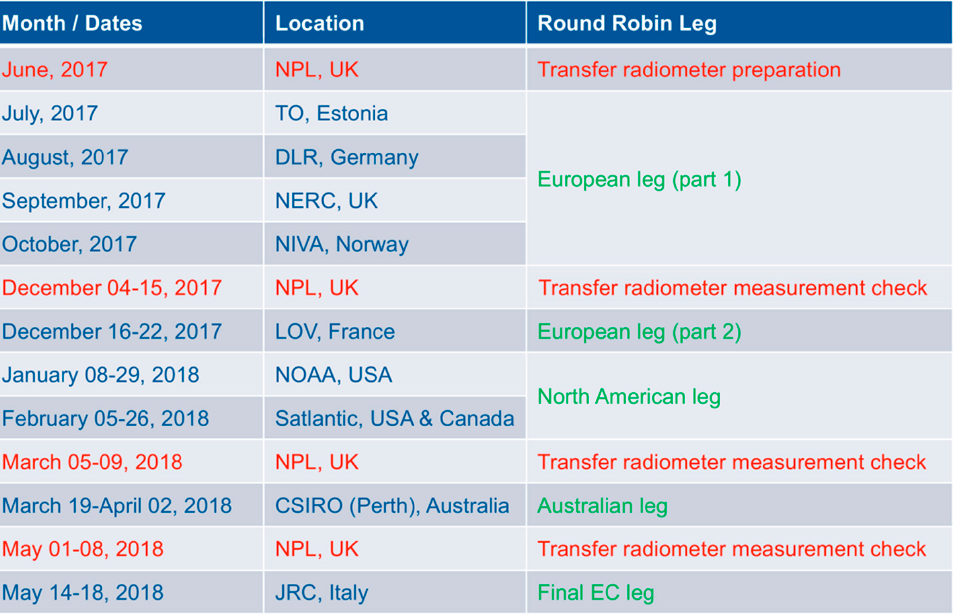
Figure 6. Schedule of the FRM4SOC international radiance round robin.